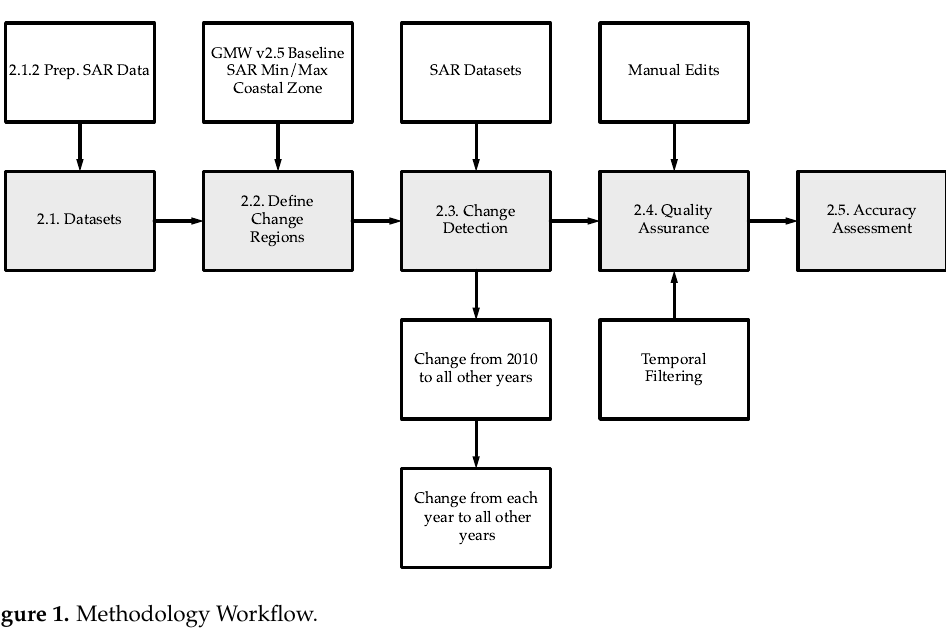
Figure 1. Methodology